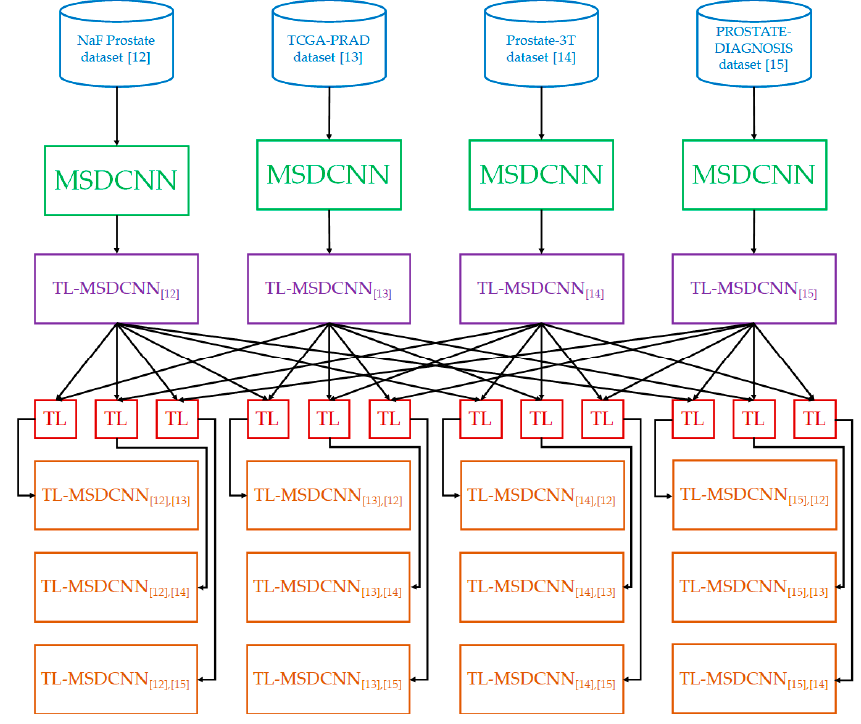
Figure 3. Architecture of the transfer learning with MCDCNN.